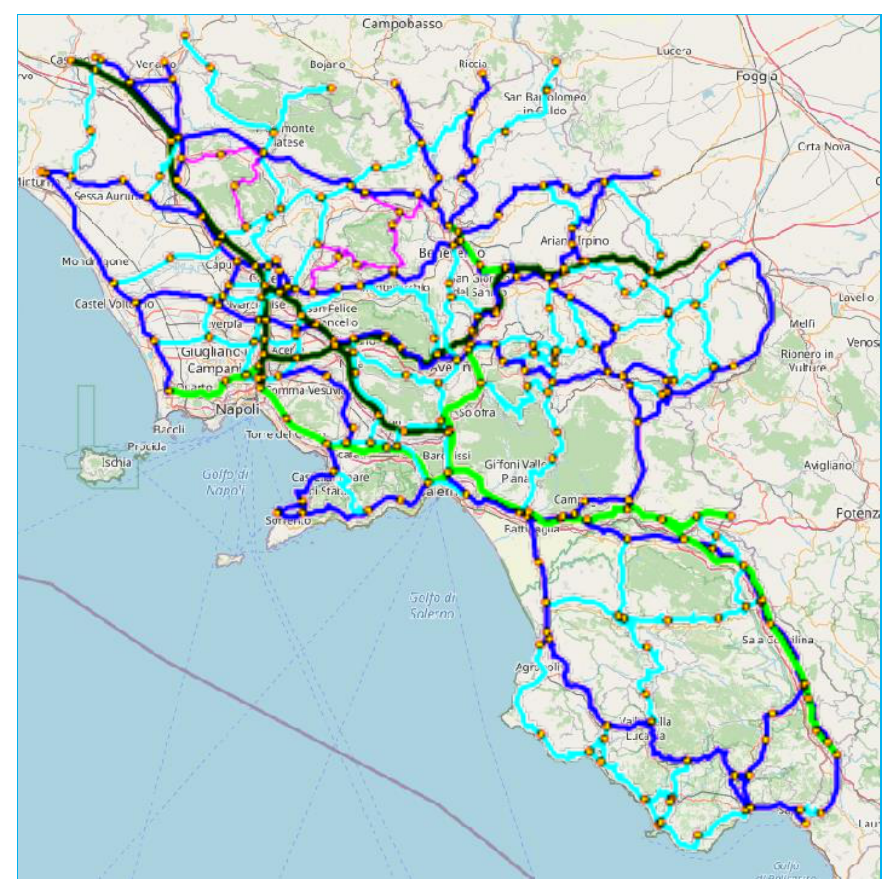
Figure 7. Rural real-scale